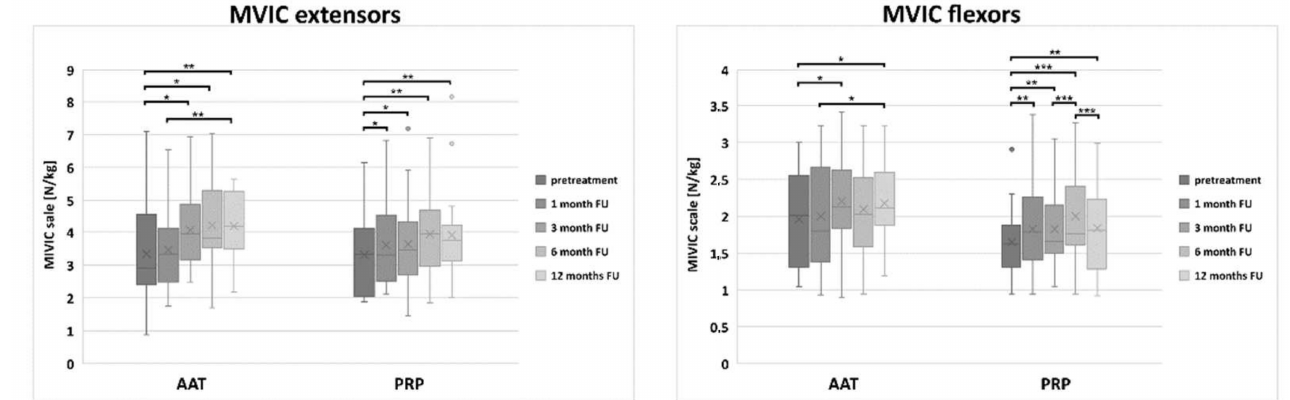
Figure 6. The distribution of the MVIC score values in the PRP and the AAT treatment groups. Central lines represent the medians, boxes indicate the range from 25th to 75th percentile, whiskers extend 1.5 times above the interquartile range and outliers are represented as dots. The significance was designated as * p < 0.05, ** p < 0.01 and *** p <